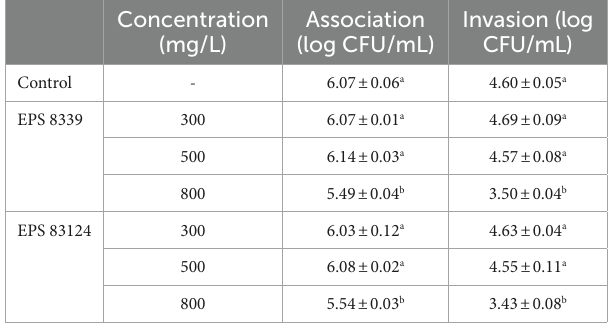
Control corresponds to cells preincubated with DMEM. Different letters within columns indicate significant differences ( p < 0.05, Tukey’s multiple comparison